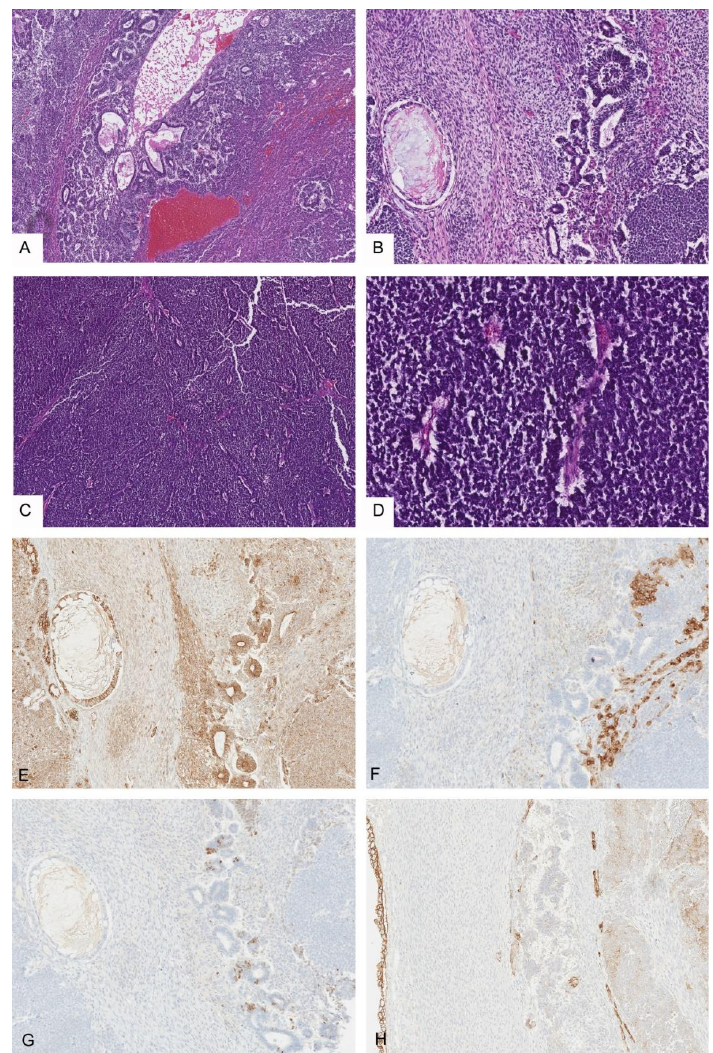
Figure 2. Teratoid HB with extensive primitive neuroepithelium and PNET-like areas. ( A , B ) THB17 with primitive neuroepithelium, variably differentiated glandular elements, 4x, 10x; ( C , D ) extensive PNET-like areas in THB17, 4x, 20x; ( E ) beta-catenin IHC 10x; ( F ) glypican-3 IHC 10x; ( G ) SALL4 IHC 10x; ( H ) MOC31 IHC 10x. A significant number of teratoid tumors contained glandular components ( n = 16). In a few cases (THB18, THB24) the glandular components demonstrated differentiation, recapitulating gastrointestinal or mature mucinous epithelium, but in many cases the glands appeared primitive, defying definitive classification. These primitive glandular components often had subnuclear and/or supranuclear vacuoles and a subset had sig-